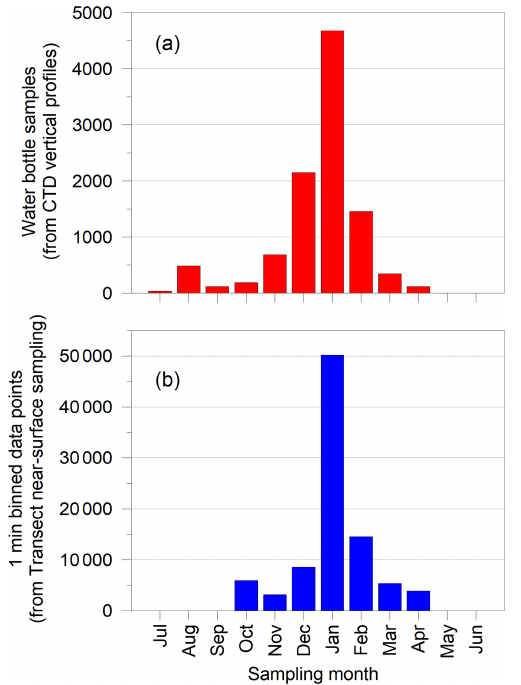
Figure 5. Monthly totals for nutrient samples from CTD water bot- tles and transect data points.